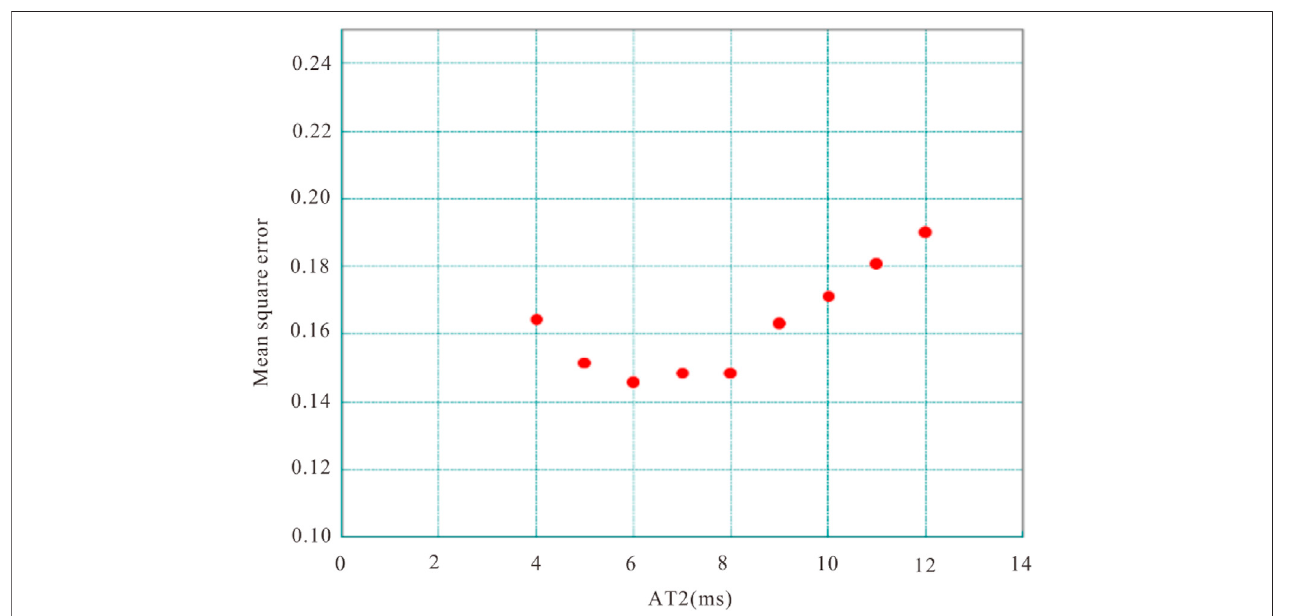
FIGURE 13 | Mean square error calculated by different AT 2 values in Well